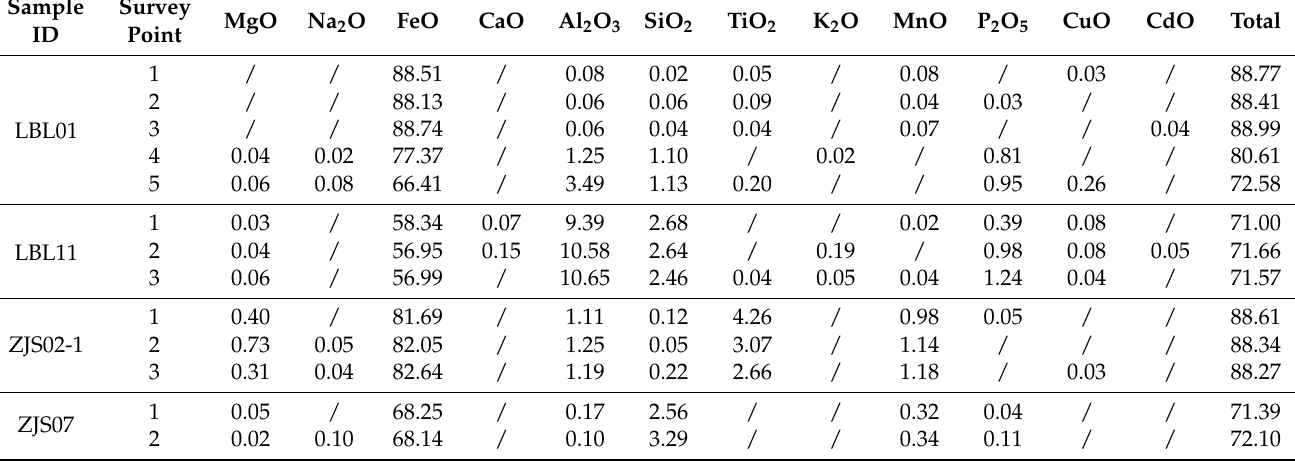
Table 3. Electron microprobe analysis results of iron oxides in stream sediments (unit: %).